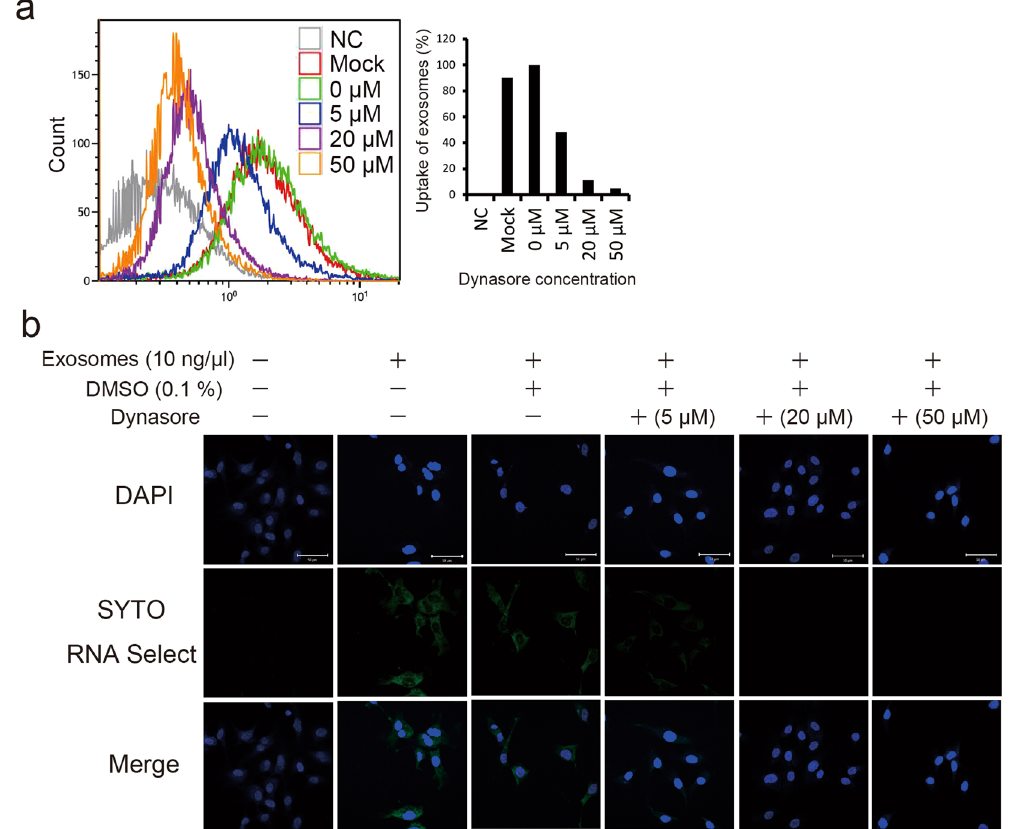
Figure 2. Uptake of exosomes released from PK-45H cells into HUVECs. ( a ) Effects on the uptake of exosomes by dynasore treatment using the FACS Aria. Exosomes were stained by the SYTO RNA Select Reagent and added to the culture media of dynasore-treated or untreated HUVECs. Treatment with > 5 µ M dynasore inhibited exosome uptake. ( b ) Effects on exosome uptake at 3 h after dynasore treatment observed under a confocal laser scanning microscope (LSM710; Carl Zeiss). Nucleus was stained by DAPI. Scale bar : 50 µ